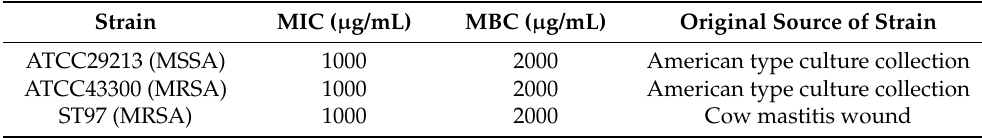
Table 1. Minimum inhibitory concentration (MIC) and minimum bactericidal concentration (MBC) of juglone against S. aureus.